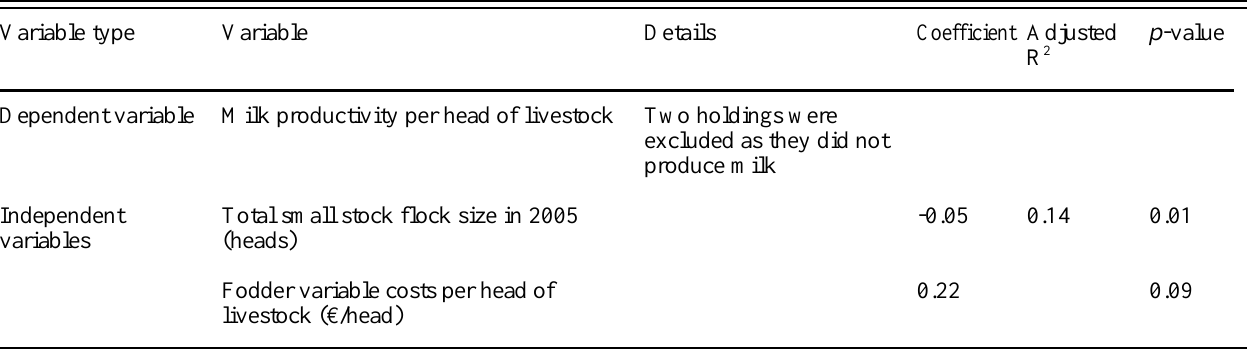
Table 8. Linear regression results for stock-breeding intensification and flock size as explanatory variables for change in stock productivity ( n =